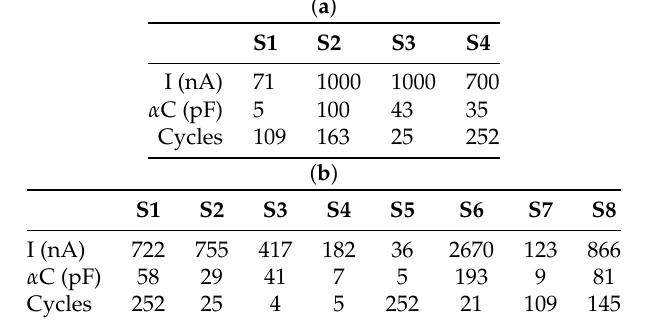
Table 3. Sporadic module parameters of the ( a ) single-level ( b ) hierarchical activity monitoring